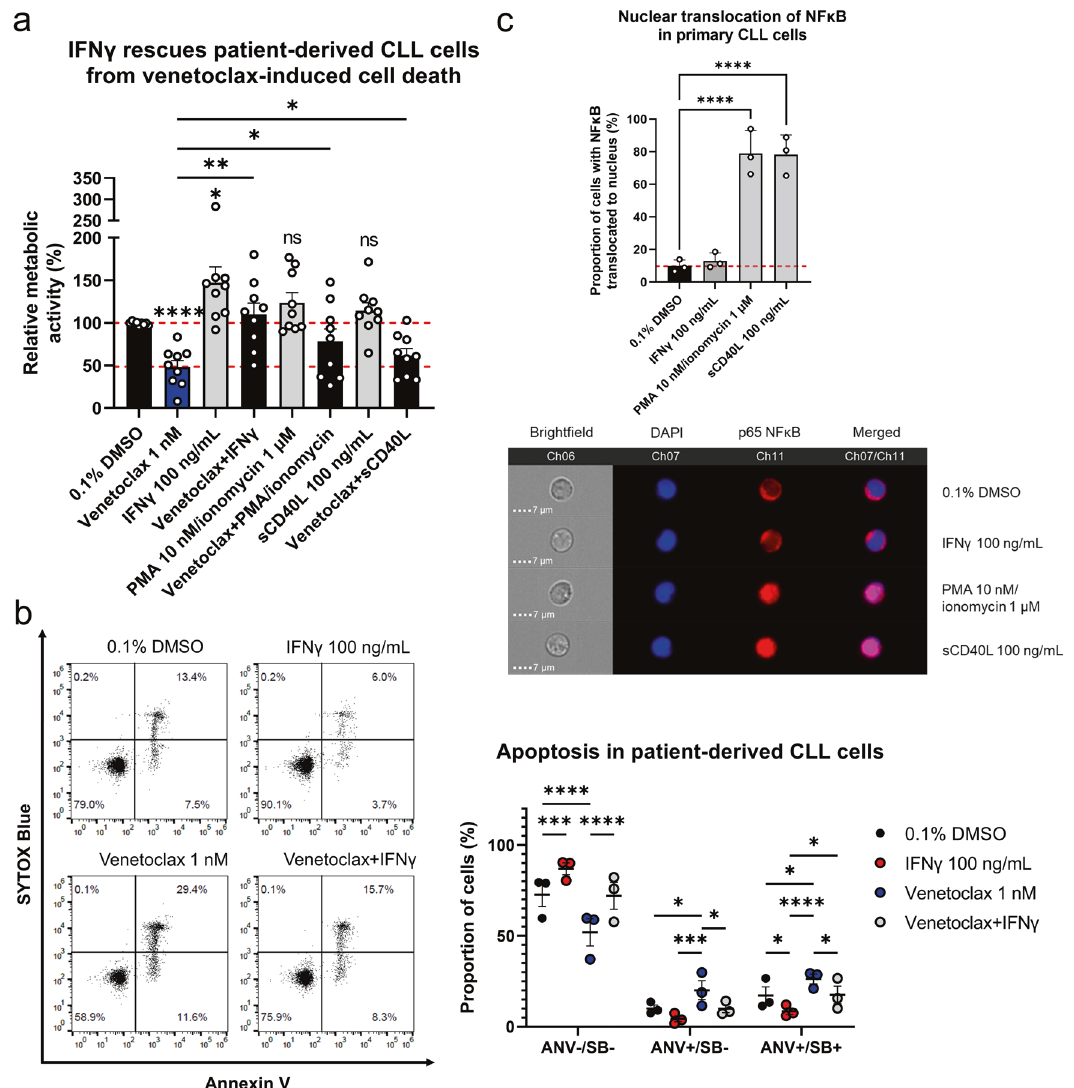
Fig. 1 IFN γ rescues CLL cells from spontaneous and venetoclax-induced cell death. a Diverse stimulants abrogate venetoclax cytotoxicity against patient-derived CLL cells. Primary cells (1 × 10 6 cells/mL) obtained from nine patients with CLL were treated with 0.1% DMSO (vehicle control), and 1 nM venetoclax alone and in combination with 100 ng/mL IFN γ , 10 nM PMA/1 µM ionomycin, and 100 ng/mL sCD40L for 24 h. The metabolic activities of the cells were determined using the PrestoBlue assay. Data are means ± SEM of ≥ three independent experiments, each carried out in duplicate. Two-way ANOVA (post hoc Tukey); *, **, and **** denote p < 0.05, p < 0.01, and p < 0.0001, respectively; b Cytoprotective effects of IFN γ in the patient-derived CLL cells undergoing spontaneous and venetoclax- induced apoptosis. CLL cells (1 × 10 6 cells/mL) were treated with 0.1% DMSO (vehicle control) and 1 nM venetoclax, 100 ng/mL IFN γ , and their combination for 24 h. Apoptosis was assessed using the SYTOX Blue/annexin V assay. Representative dot plots (left) and means ± SEM of three independent experiments (right) are shown. Two-way ANOVA (post hoc Tukey); *, **, ***, and **** denote p < 0.05, p < 0.01, p < 0.001, and p < 0.0001, respectively; c Nuclear translocation of NF κ B in the primary CLL cells. CLL cells (1 × 10 6 c ells/mL) from three patients with CLL were treated with 0.1% DMSO (vehicle control), 100 ng/mL IFN γ , 10 nM PMA/1 µM ionomycin, and 100 ng/mL sCD40L for 1 h. Quanti fi cation (left) and representative images (right) are shown for the translocation of NF κ B to the nucleus, using imaging fl ow cytometry. One-way ANOVA (post hoc Dunnett); **** denotes p <